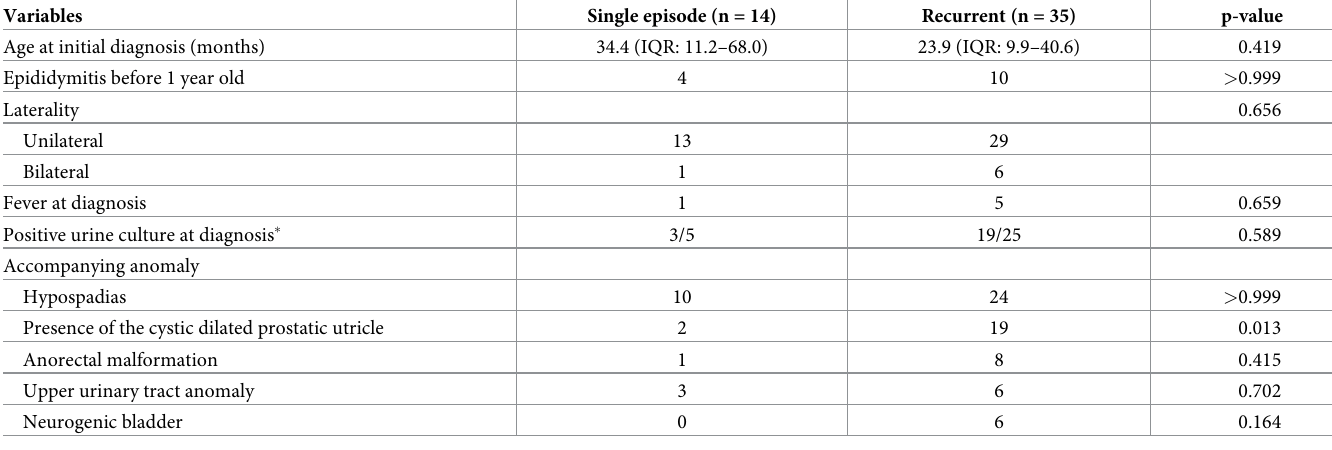
Table 3. Comparison of clinical parameters between patients with single episode of epididymitis and recurrent epididymitis in patients with known genitourinary anomalies (N = 49). Variables Single episode (n = 14) Recurrent (n = 35) p-value Age at initial diagnosis (months) 34.4 (IQR: